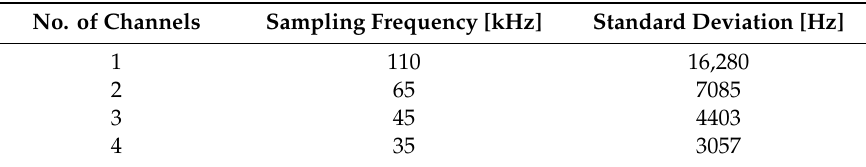
Table 5. Details of the recording capacity of the equipment per